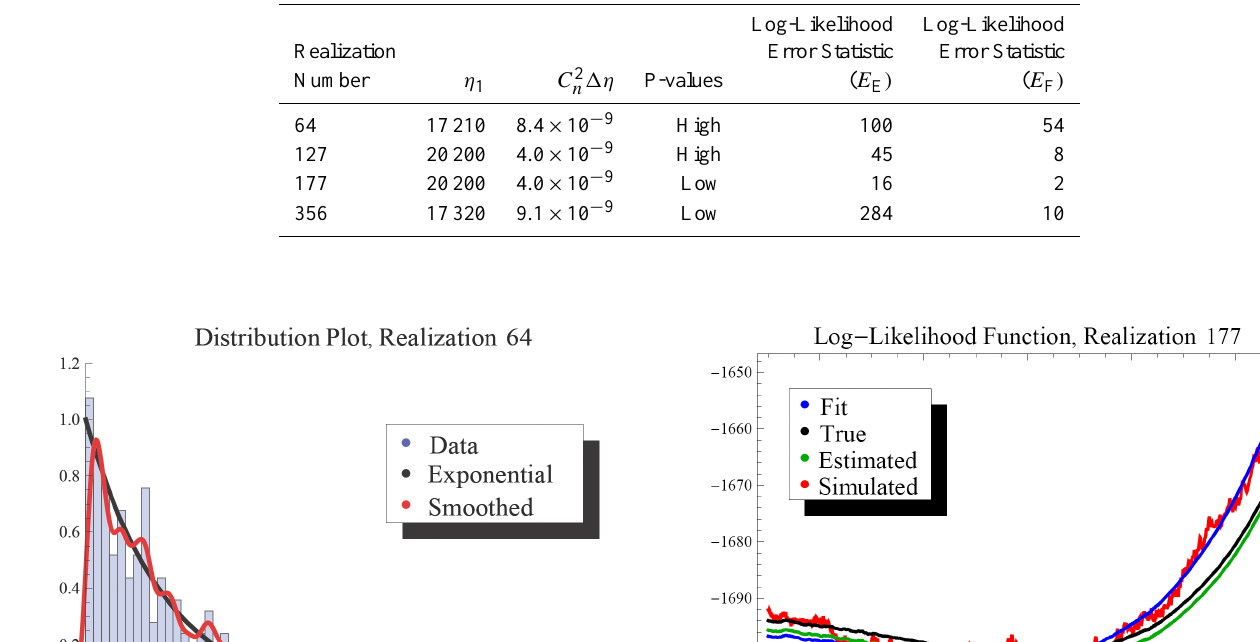
Table 3. Parameter estimates and statistical measures for selected realizations.